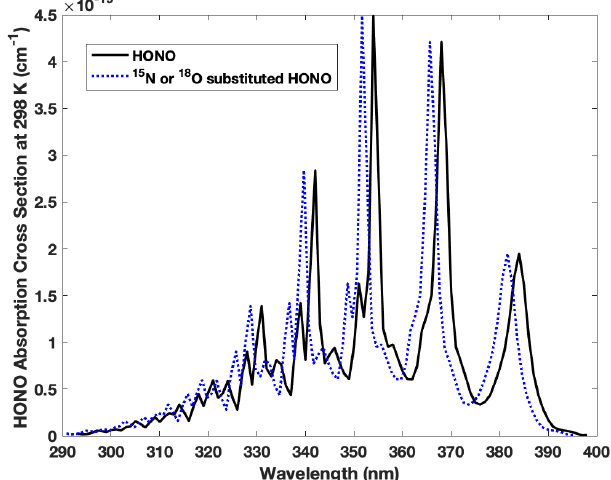
Figure B1. Absorption wavelengths shift for HO 15 NO, H 18 ONO and HON 18 O compared with the most abundant form of HONO (H 16 O 14 N 16 O). The spectra of HO 15 NO, trans-H 18 ONO and trans-HON 18 O are blue shifted 0.23–0.43, 0.21–0.39 and 0.25– 0.46nm, respectively, spanning 293–398nm. Note that the blue shift illustrated here is 2nm (larger than the actual shift) in order to demonstrate the shift